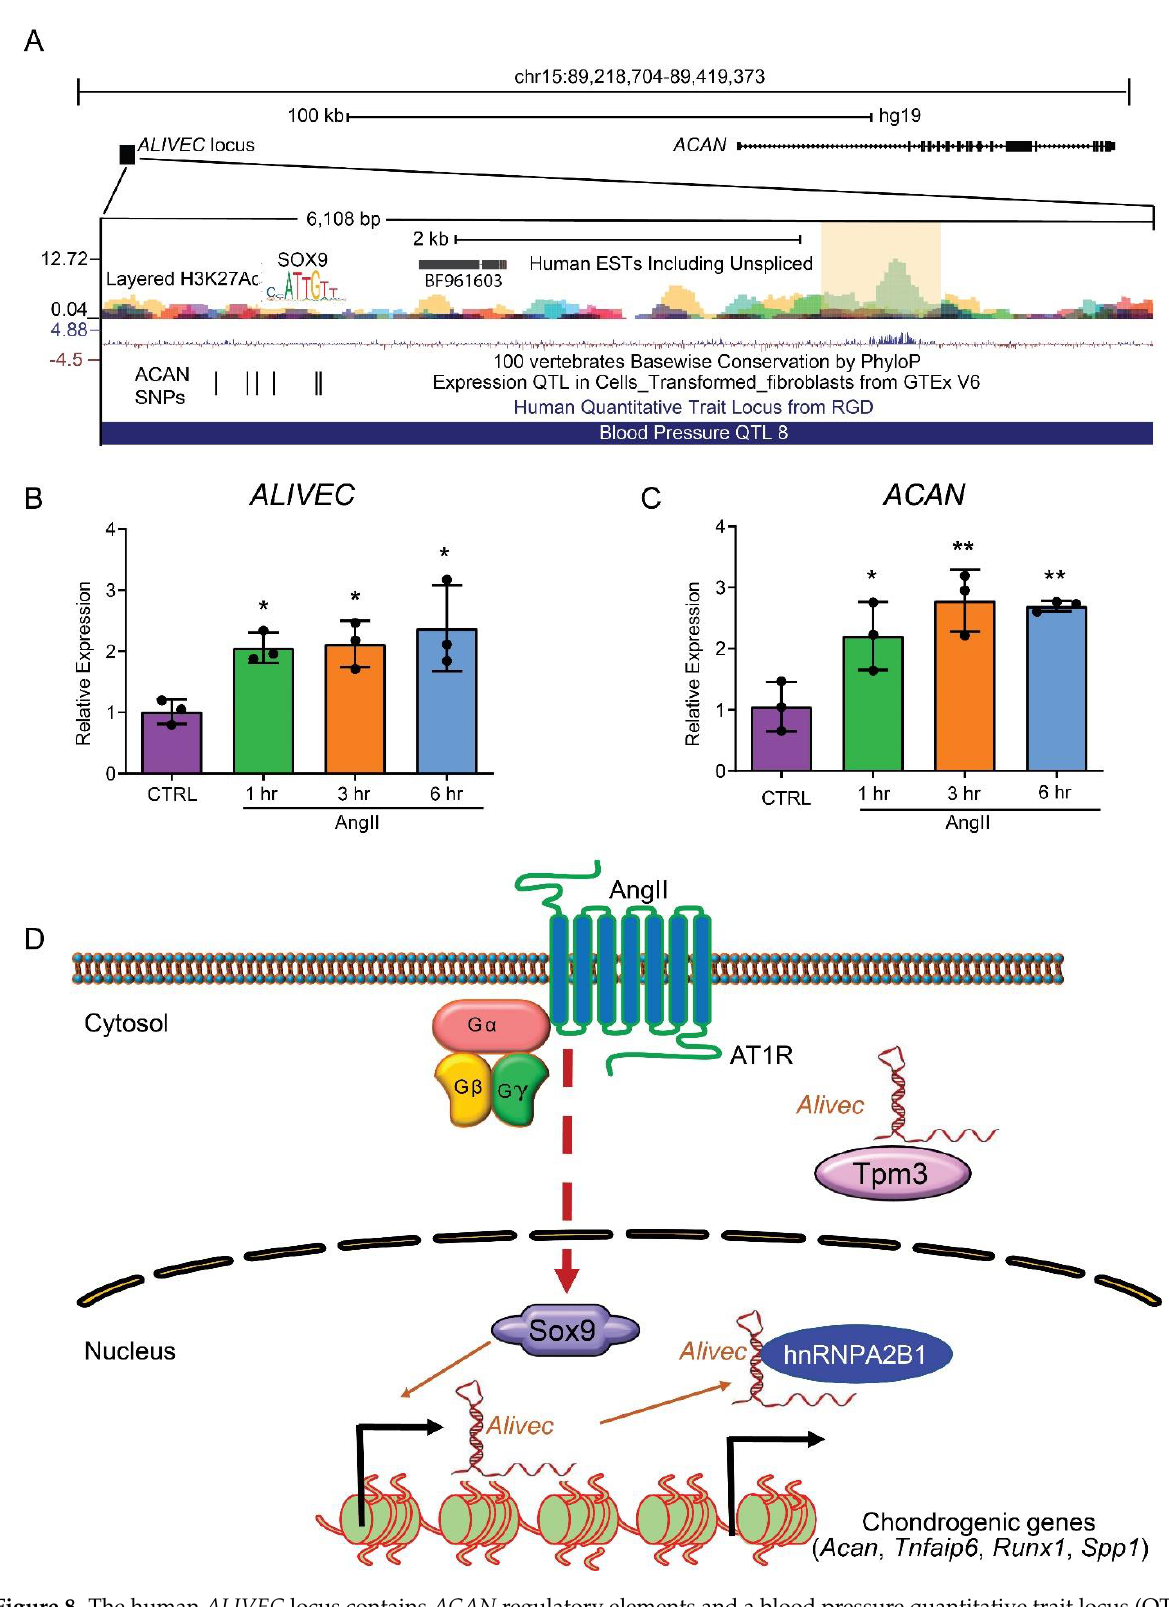
Figure 8. The human ALIVEC locus contains ACAN regulatory elements and a blood pressure quantitative trait locus (QTL). ( A ) UCSC human genome browser tracks showing ACAN to the right, ALIVEC locus to the left and is enlarged showing BF961603 EST (potential ALIVEC ), ACAN regulating enhancer (light yellow shaded region), expression QTLs (eQTLs) that regulate ACAN expression and a blood pressure-associated QTL 8, stretching through ALIVEC locus. ( B , C ) HVSMCs were treated with ± AngII (100 nM) for the indicated time periods and RT-qPCR analysis of ALIVEC and ACAN expression was performed. Data presented as mean ± SD, n = 3 biological replicates and one- way ANOVA with Dunnett’s